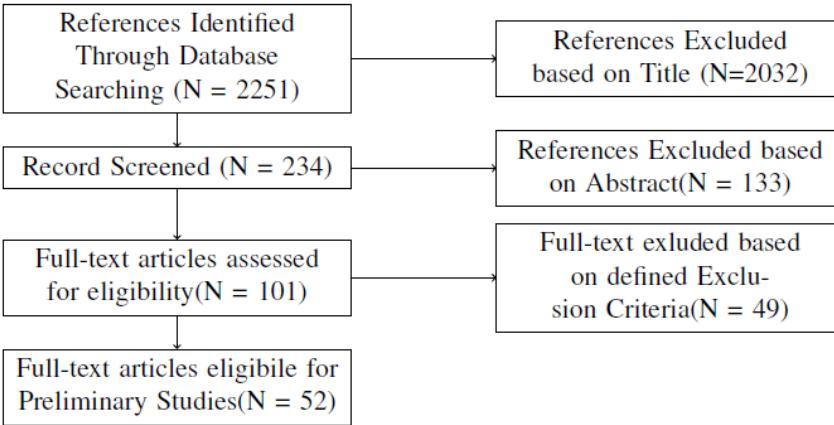
Figure 1. Procedure of research selection for the present schematic review. Table 4. Inclusion and exclusion criteria